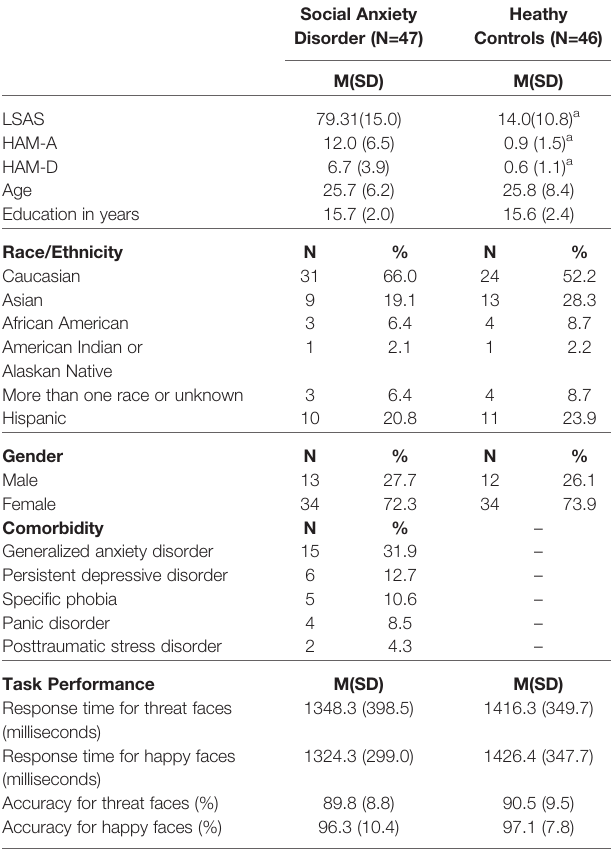
TABLE 1 | Demographic and clinical characteristics and task